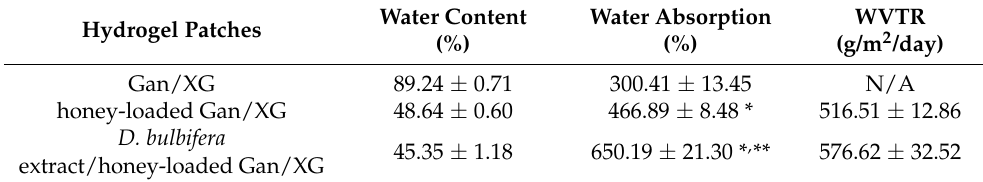
Table 3. The physical properties of the hydrogel patches. Hydrogel Patches